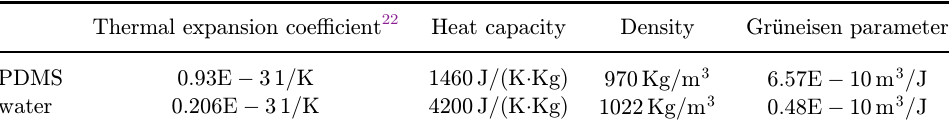
Table 1. Comparison of thermoelastic parameters for PDMS and water.